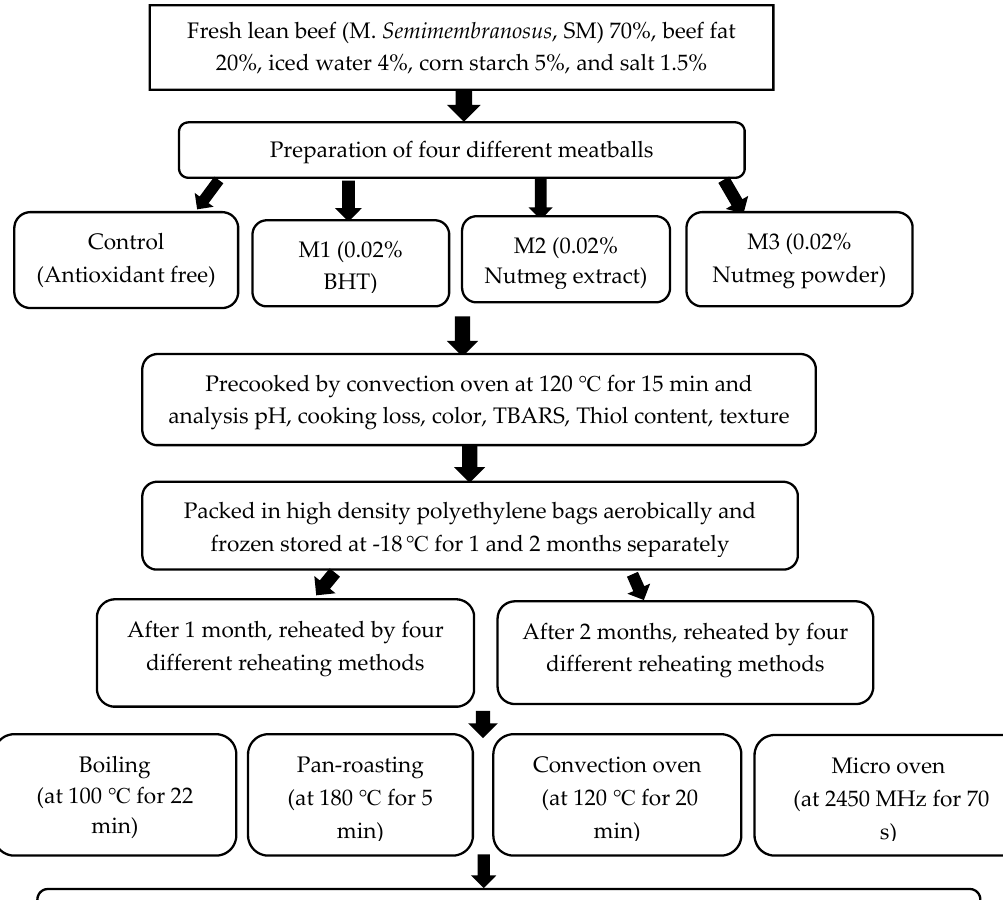
Figure 1. Diagram of used experimental design .